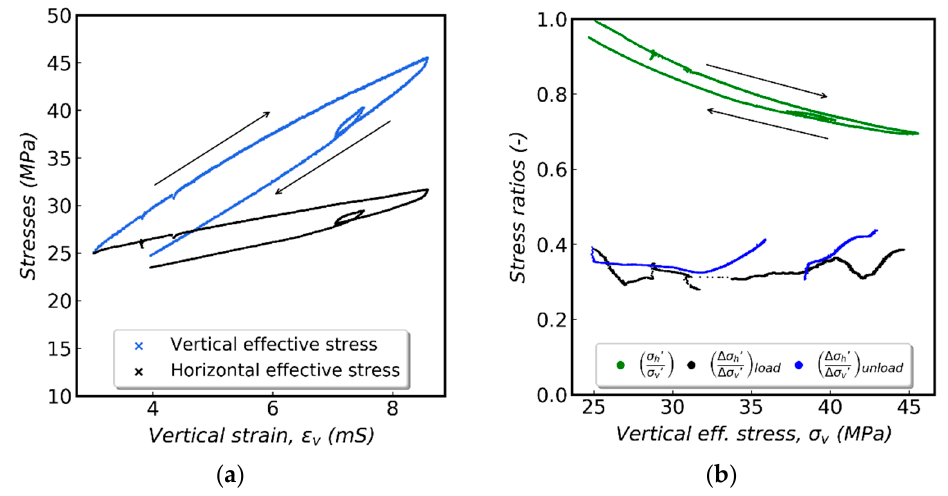
Figure 6. ( a ) Stress evolution versus vertical strain and ( b ) the ratio of principal stresses and ratio of change in principal stresses (the black line from loading and the blue line from unloading) versus effective vertical strain from uniaxial strain loading of vertical Draupne sample.